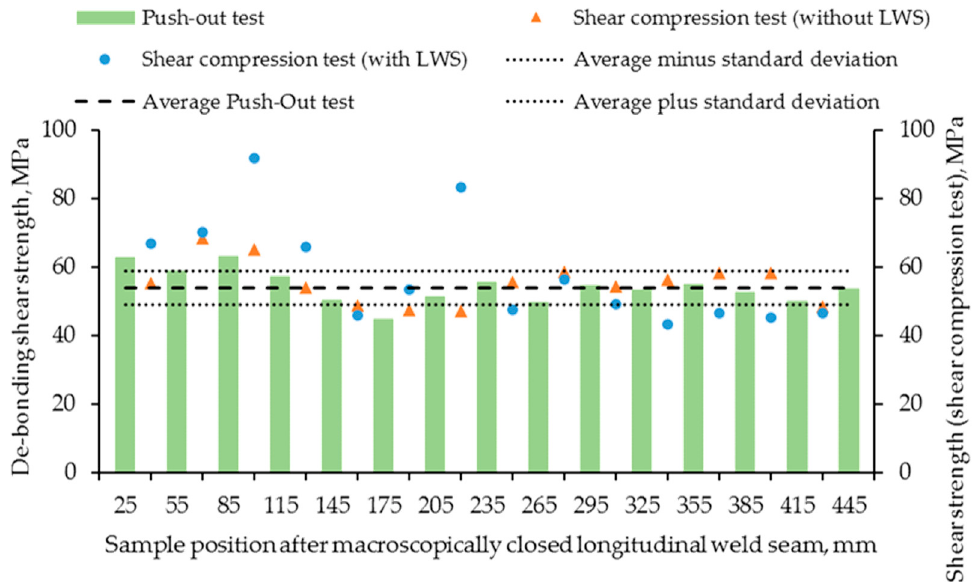
Figure 11. Determined shear strength of the compound profile with a reinforcement content of 34 vol.% starting 25 mm after macroscopically closed longitudinal weld seam with de-bonding shear strength averaged over the entire compound profile length (dashed line); dotted lines represent one standard deviation both for sample segments with and without longitudinal weld seams.